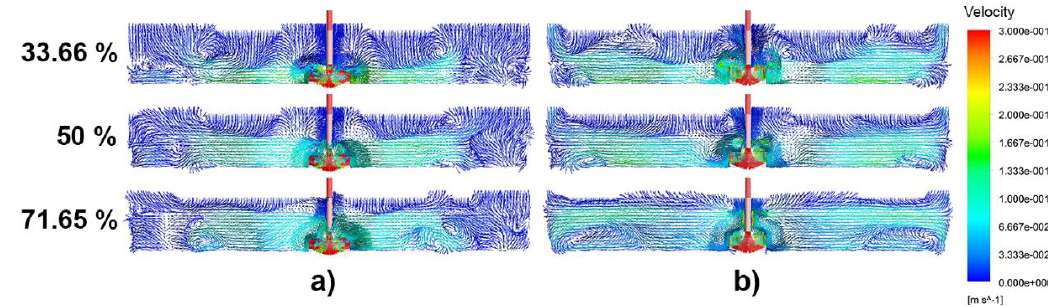
Figure 7. Velocity fields in planes passing through the ladle shroud axis at different height percentages of the operating level in the tundish: ( a ) TI1; ( b ) TI3.